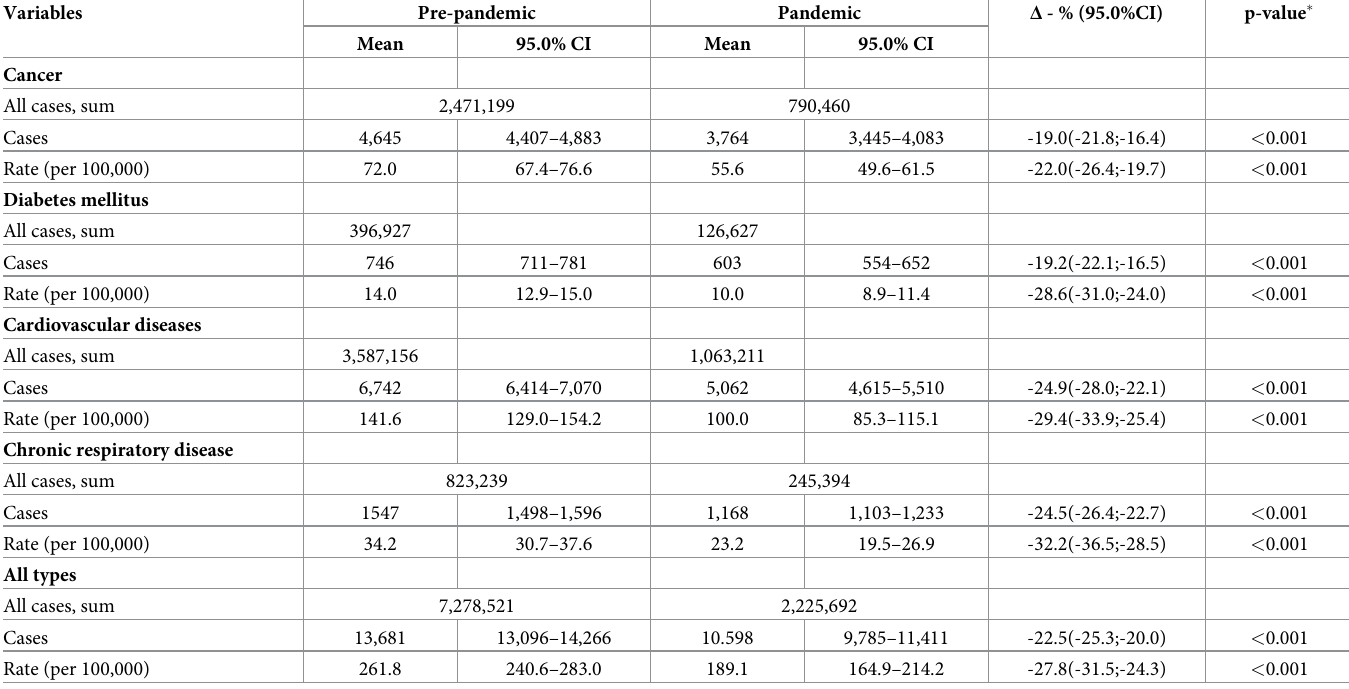
Table 1. Hospital admissions for chronic non-communicable diseases (NCDs) in Brazil before and after the onset of the coronavirus disease pandemic according to the type of NCD.